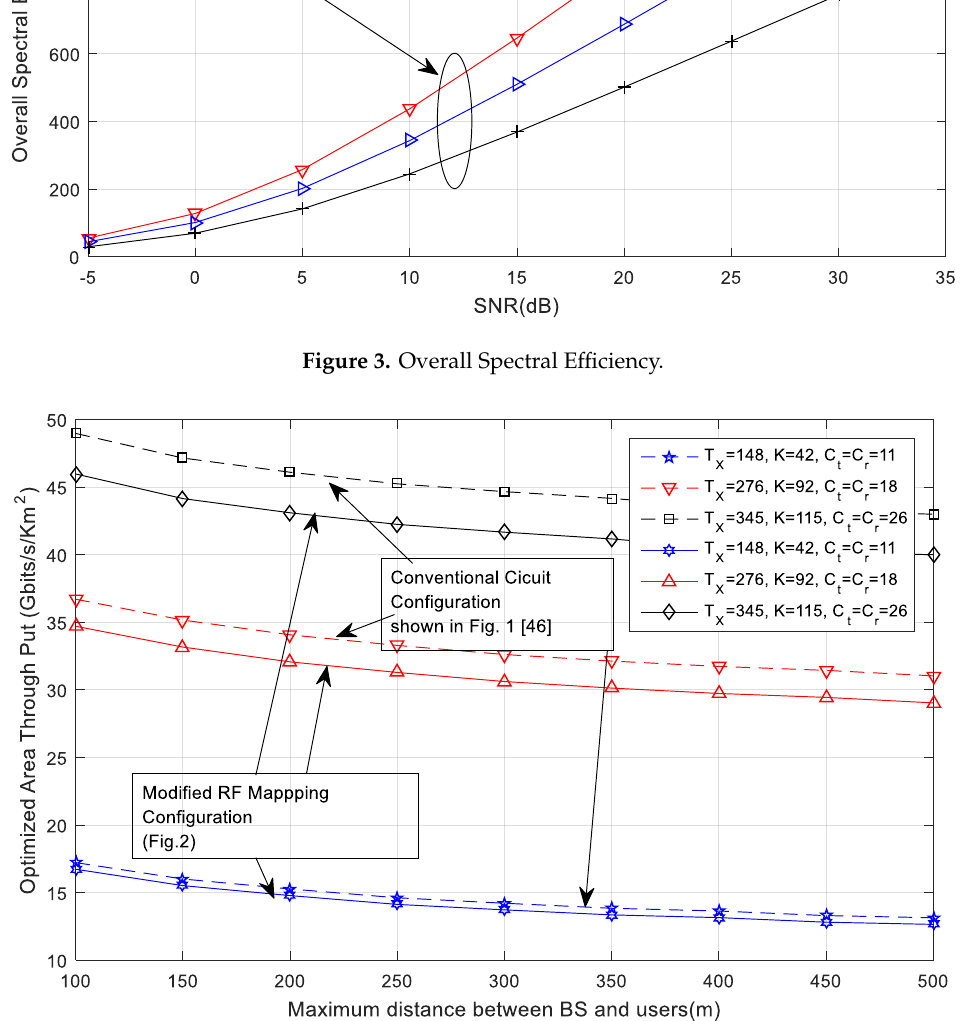
Figure 4. Optimal Area Throughput.